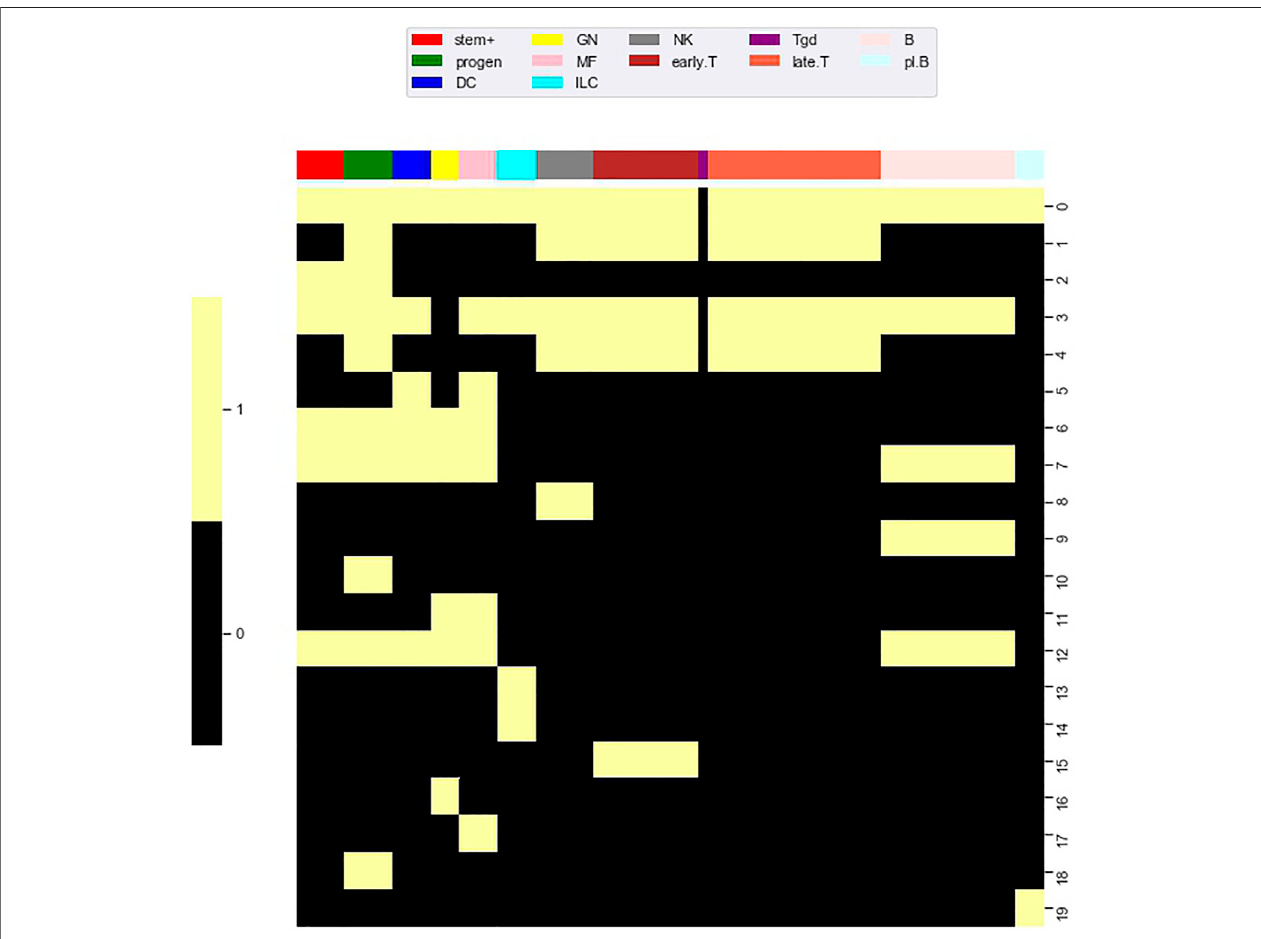
FIGURE8| Accessibilityco-clusters.ToinvestigateenrichmentofTFmotifs, wede fi ned acollection ofaccessibility co-clustersformed throughthecombinationof ( 12 ) locusclustersandallcelltypesintheaccessiblestateof ~ M i / a .Intheheatmap,accessibilityco-clustersaretheyellowblockswithineachofthe20rows,compareto in Figure 2B . As an example, accessibility co-cluster 5 is formed by the loci in locus cluster 5 and the DC and macrophage cell type clusters.